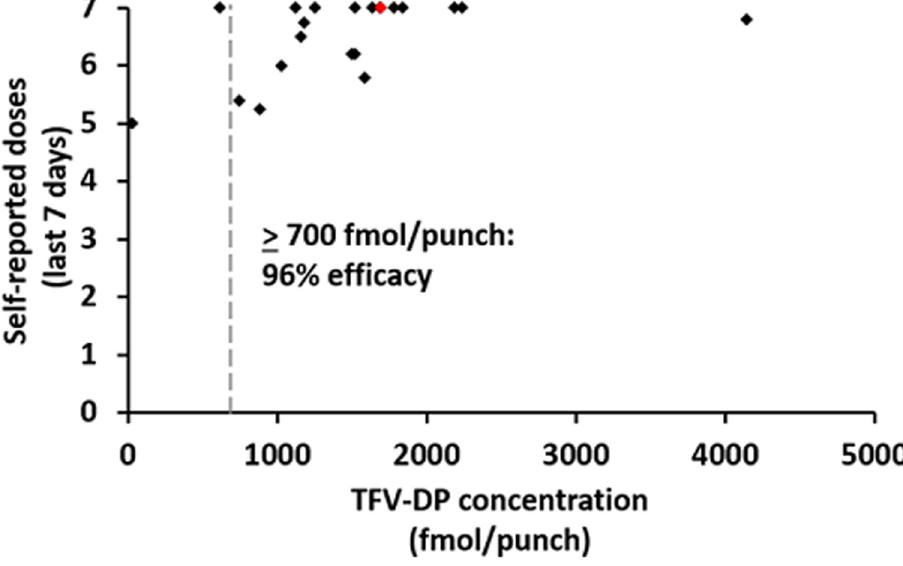
Fig 2. Tenofovir-diphosphate (TFV-DP) concentration and self-reported number of doses taken in the past seven days among pre-exposure prophylaxis (PrEP) patients (n = 21). Red marker indicates the patient who seroconverted while taking